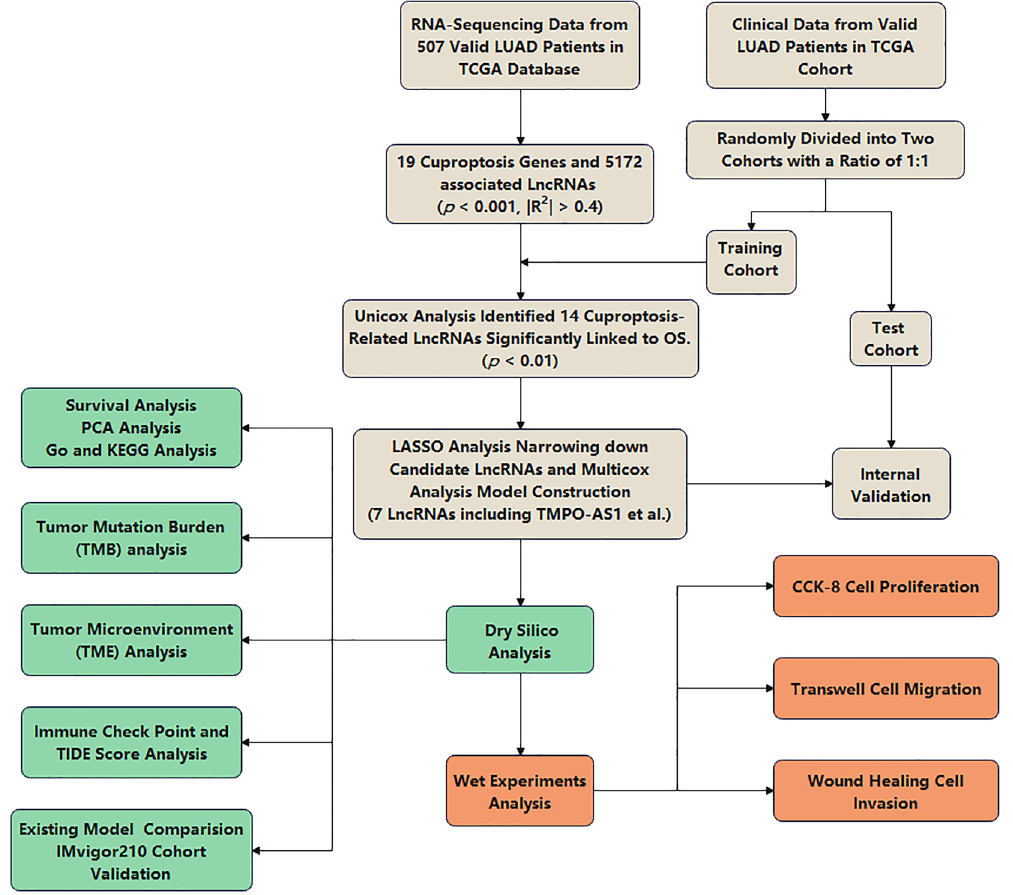
Figure 1. Flowchart of the present